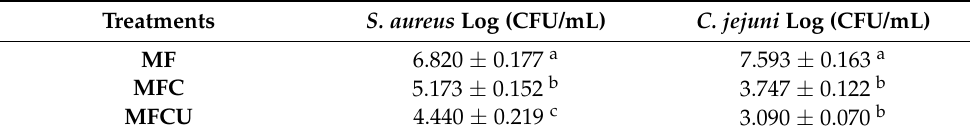
Table 4. Antimicrobial properties of mung bean flour-based films processed under different conditions.